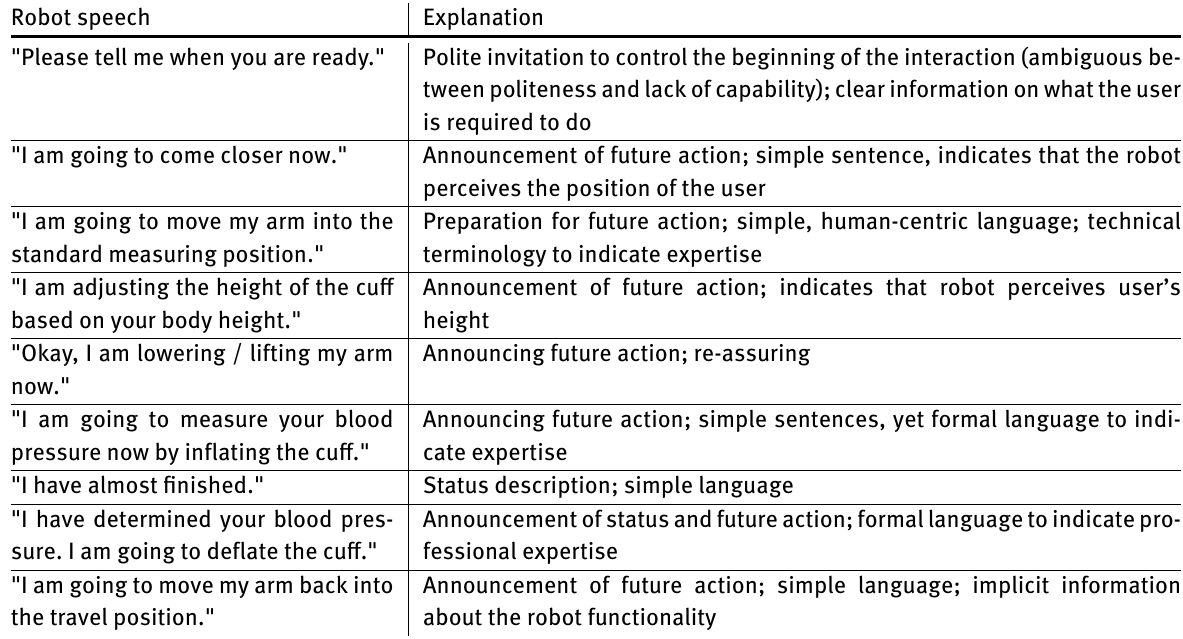
Table 2: Design rationale for the transparency communicated by the robot’s utterances Robot